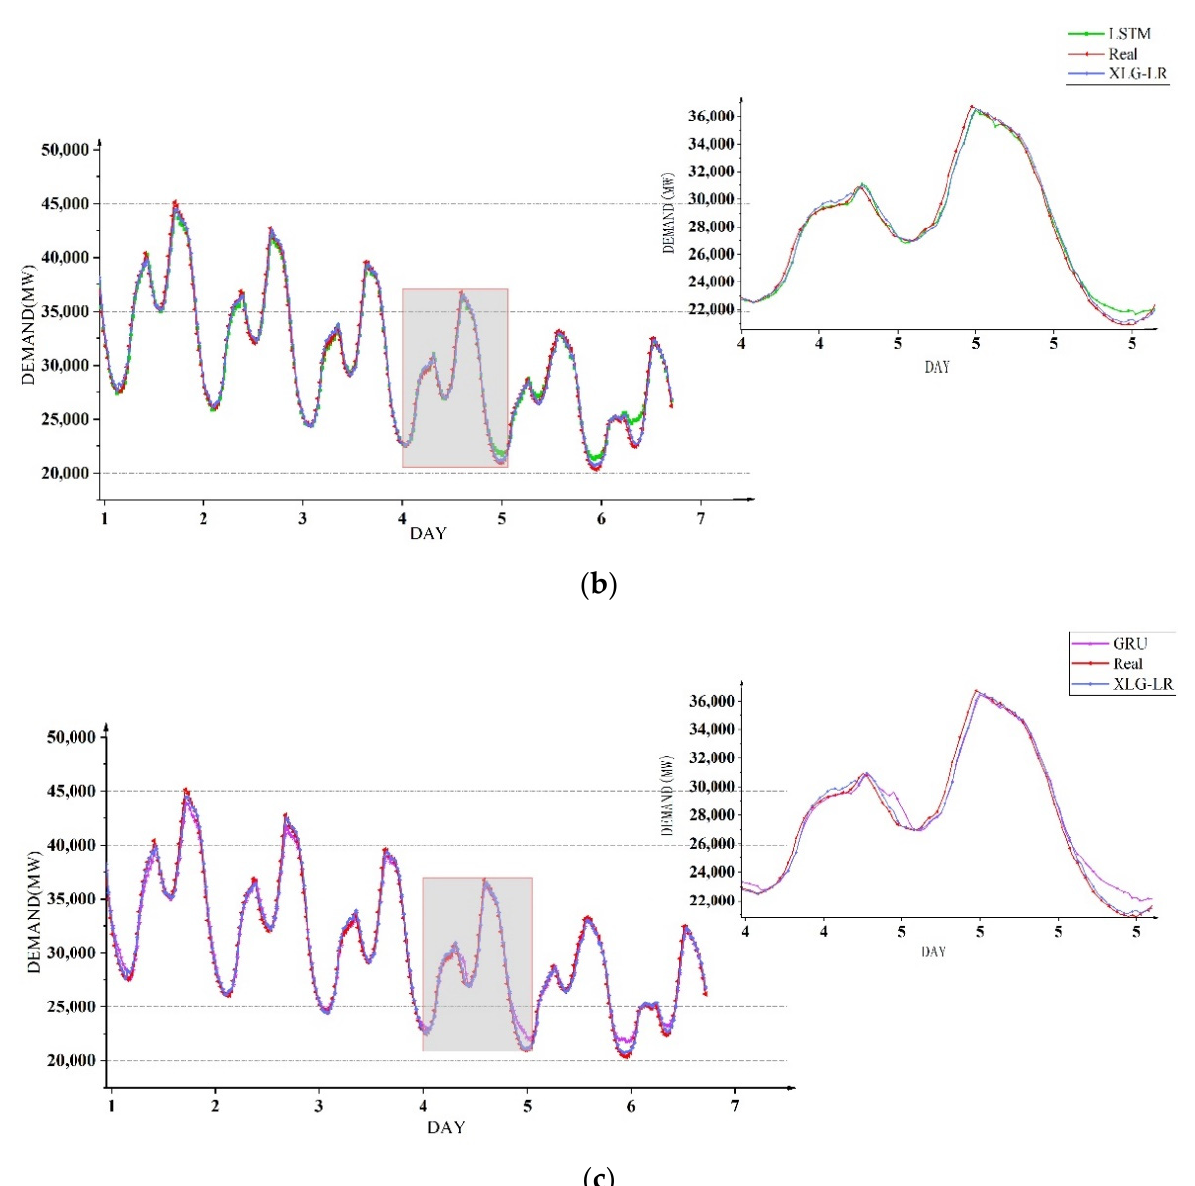
Figure 11. Comparison of Power Demand Forecasting of Different Models on a Weekly Basis. ( a ) TCN model; ( b ) LSTM model; ( c ) GRU model.